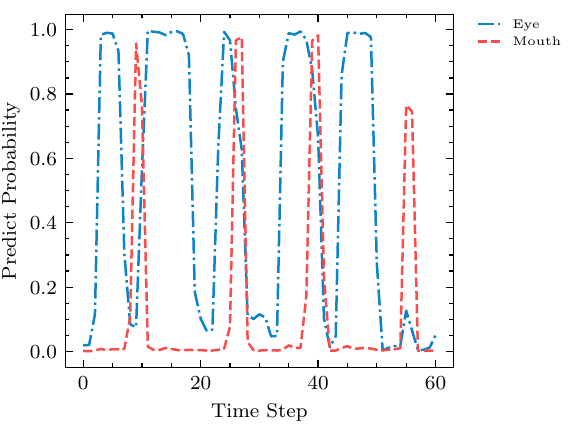
Figure 7. The factor analysis of the video sample from subject 005. The red and orange curves represent the predicted mouth and eye anomaly probabilities, respectively. The time–serial curves show the prediction results over time for a series of fatigue behaviors on the test video